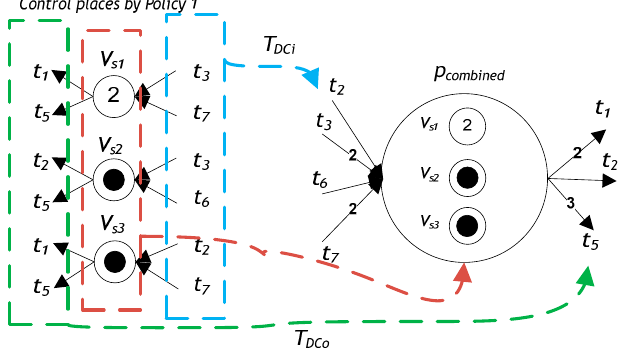
Figure 5. Output arcs of p combined for all monitors P V .